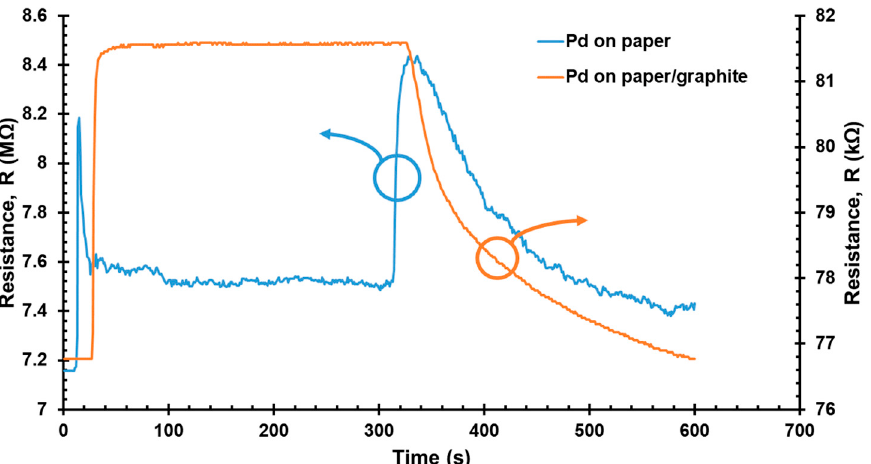
Figure 5. Resistance changes of 8 nm Pd on the normal photocopy paper (NPP) substrate and 8 nm Pd on the GOP substrate when exposed to 10,000 ppm H 2 at 25 °C.